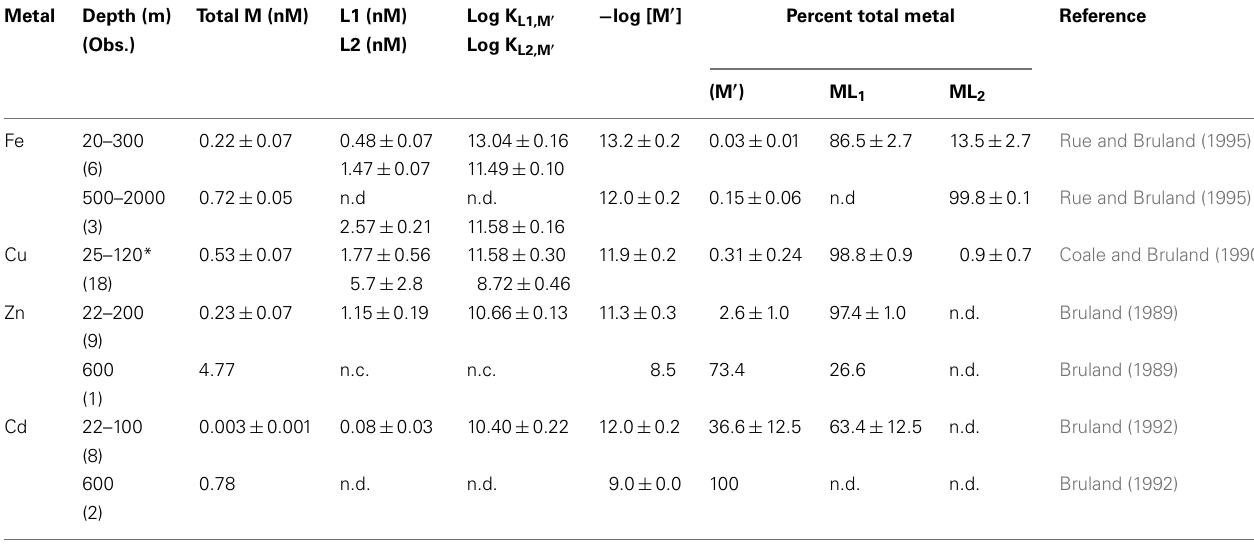
Table 1 | Organic complexation of Fe, Cu, Zn, and Cd in filtered (0.4 μ m) surface and deep waters of the Northeast Pacific Ocean (n.d. – not detected, n.c. – not